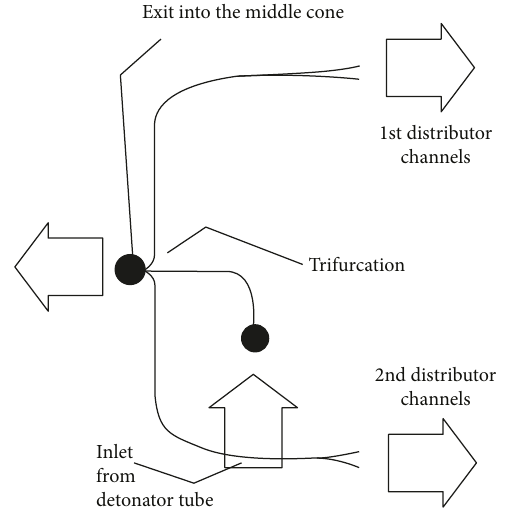
Figure 6: Milling tool trajectories of the top of outer distributor cone (Figure 5). The incoming fl ow trifurcates: two exits lead into the two outer cone channels. The third outlet enters the middle cone.